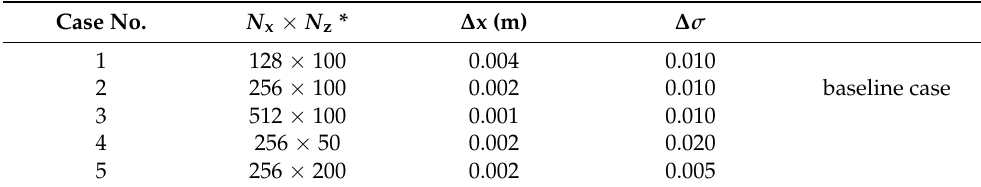
Figure 7. Schematic of the evolution of a K-H vortex at the interface.